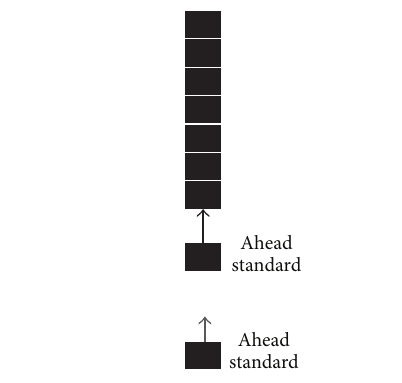
Figure 10: Basic principle for waiting cellular in the security area.